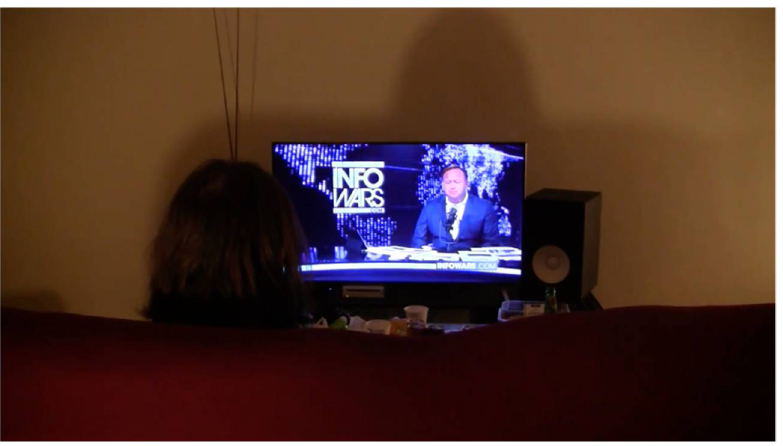
Figure 3. Student project, Conservative Vegan .